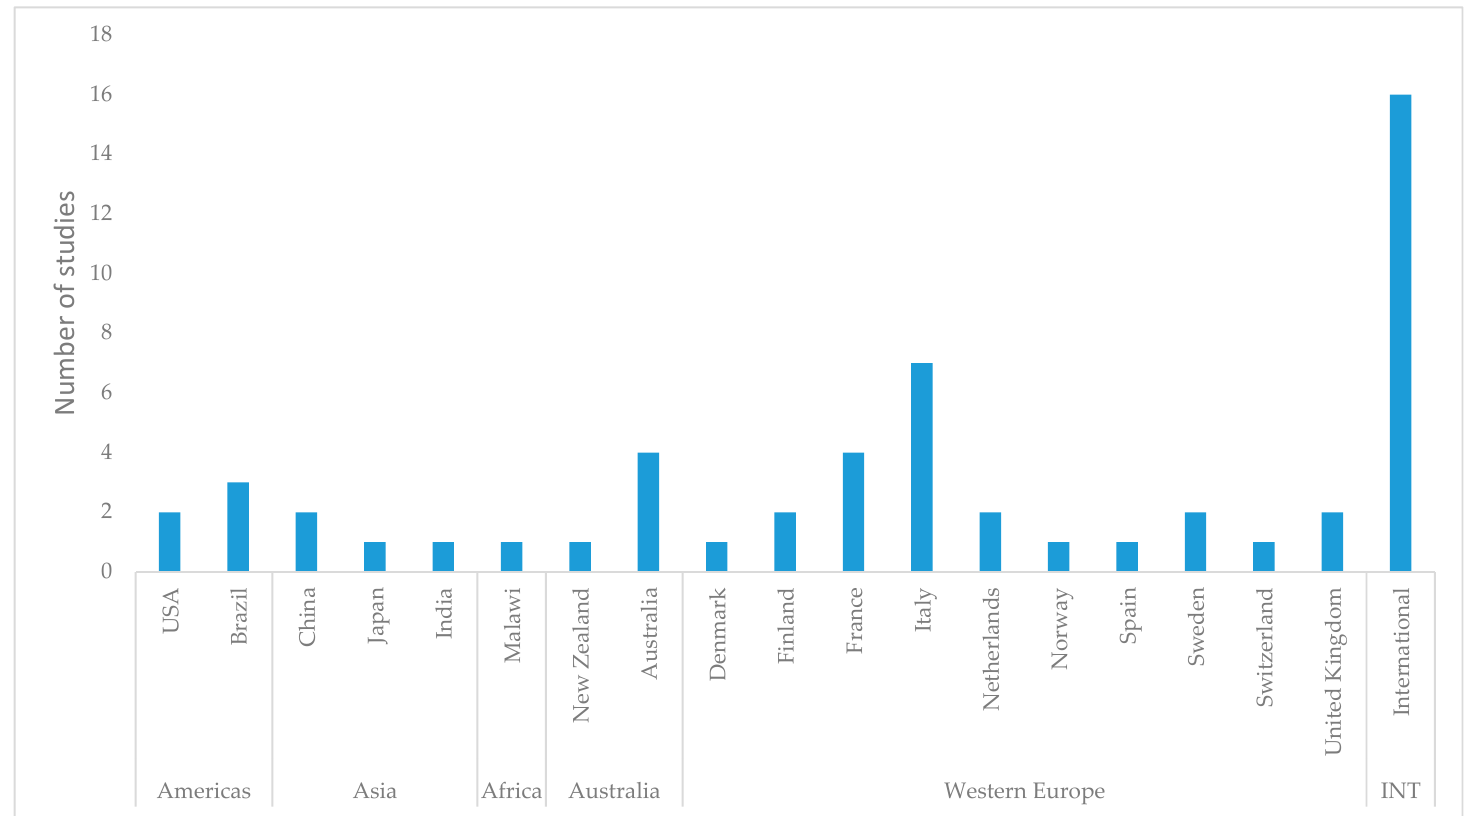
Figure 2. The distribution of the number of studies by countries and continents.